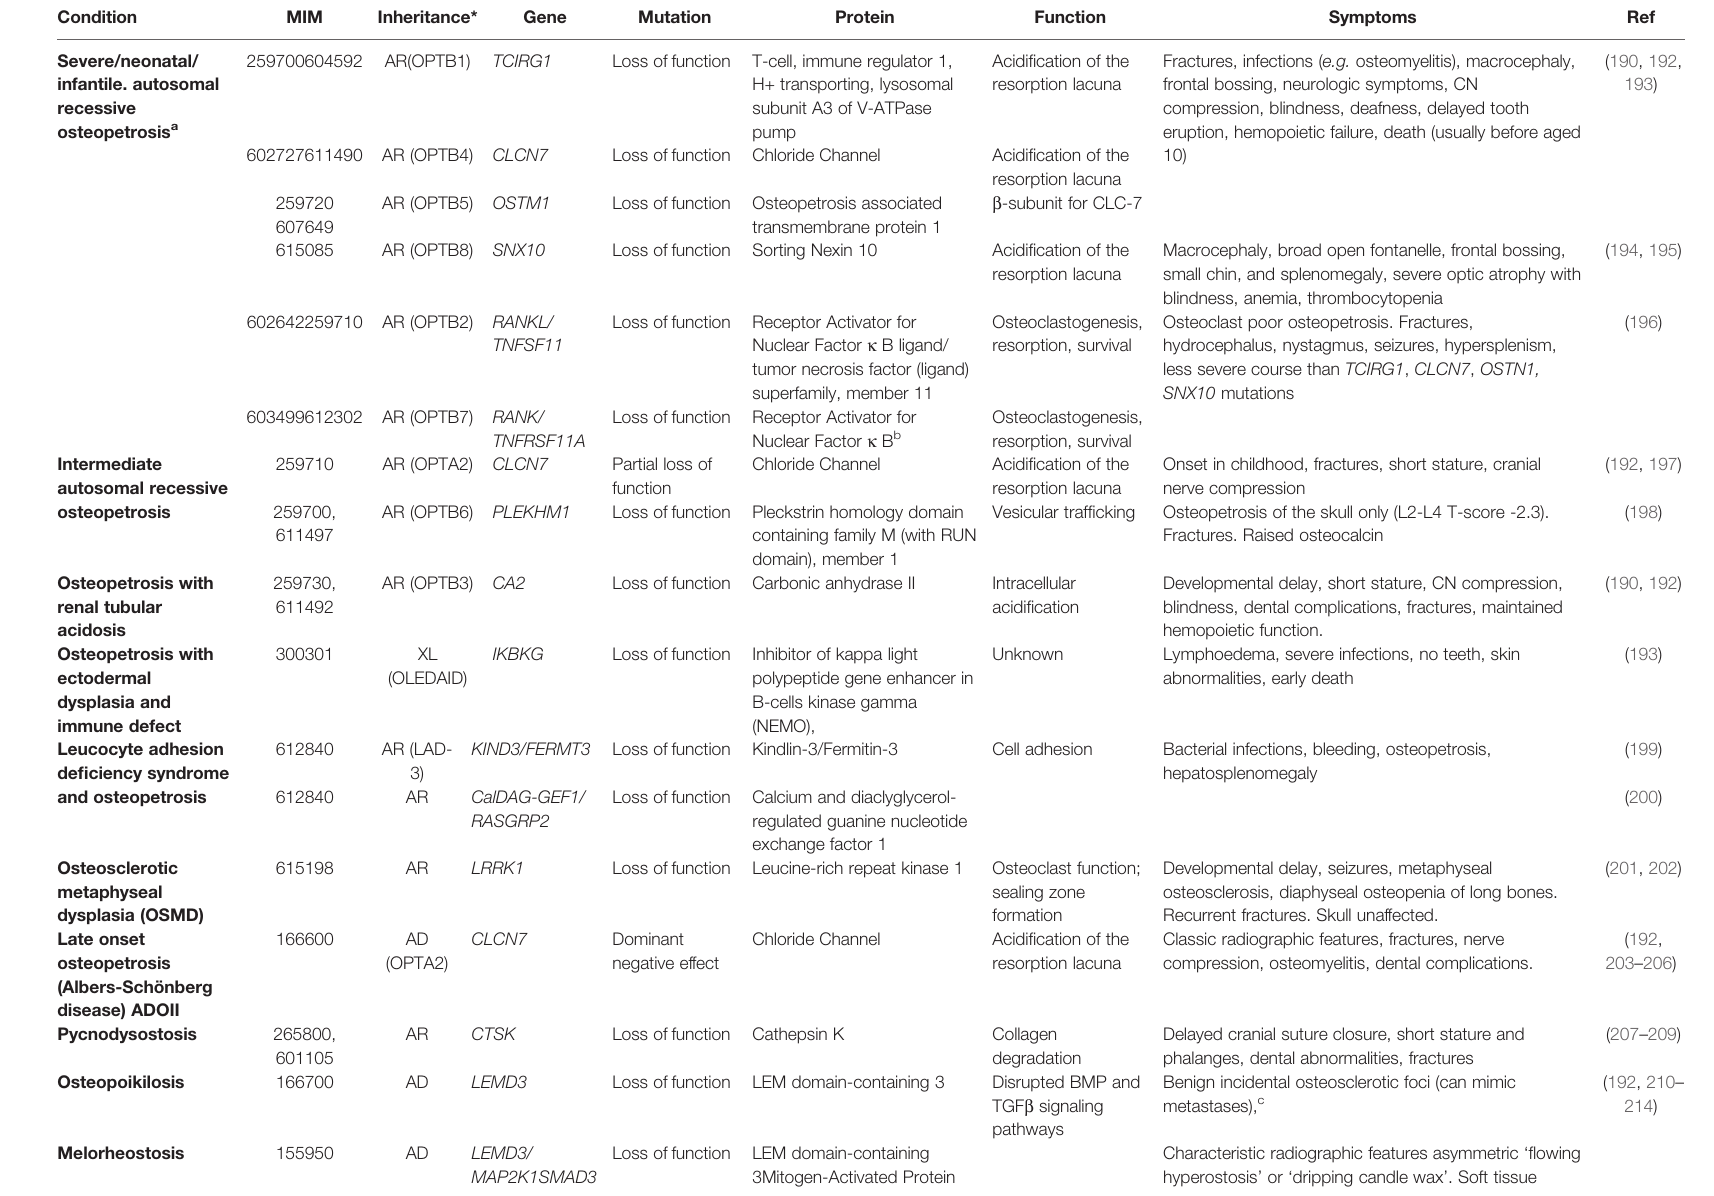
TABLE 4 | Osteopetrotic conditions and osteosclerotic conditions with disturbed formation and resorption. Condition Inheritance* Gene Severe/neonatal/ infantile.